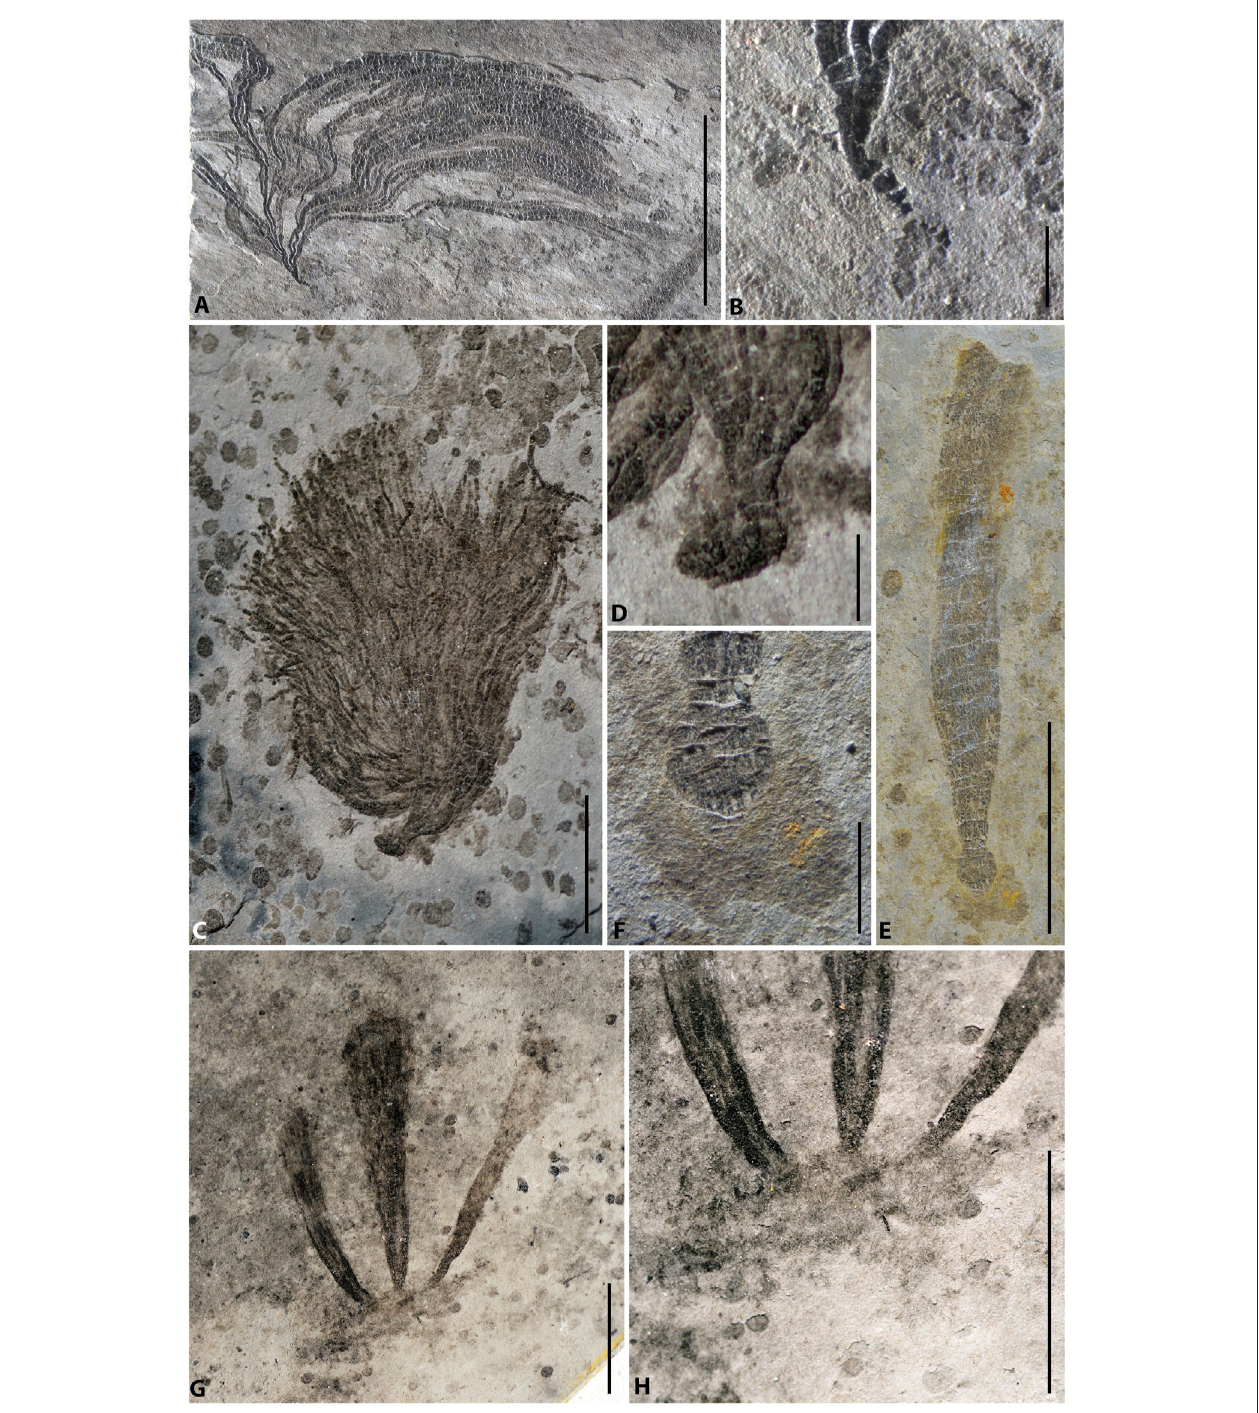
FIGURE 3 | Macroalgae and their holdfasts from the Lantian biota. (A) Doushantuophyton cometa , PB23767. (B) Enlargement of the holdfast in (A) showing a simple tapered morphology. (C) Anhuiphyton lineatum , PB23769. (D) Enlargement of the globular holdfast in (C) . (E) Flabellophyton lantianense , PB23768. (F) Enlargementoftheglobularholdfastin (E) ,withamorphous organicmass. (G) Three Flabellophyton thallirisefromacommonorganicmass,PB23770. (H) Enlargement of the holdfast in (G) . Scale bars represent 10 mm (A,C,E,G) and 1 mm (B,D,F,H) .